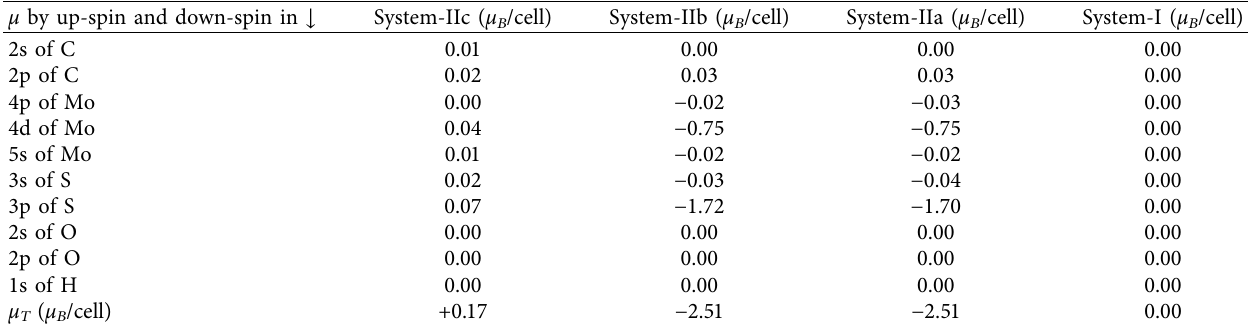
Table 2: Total magnetic moment ( µ T ) due to up-spin and down-spin state of electrons in the orbitals of C, Mo, S, O, and H atoms in PDOS of system-I, system-IIa, system-IIb, and system-IIc. µ by up-spin and down-spin in